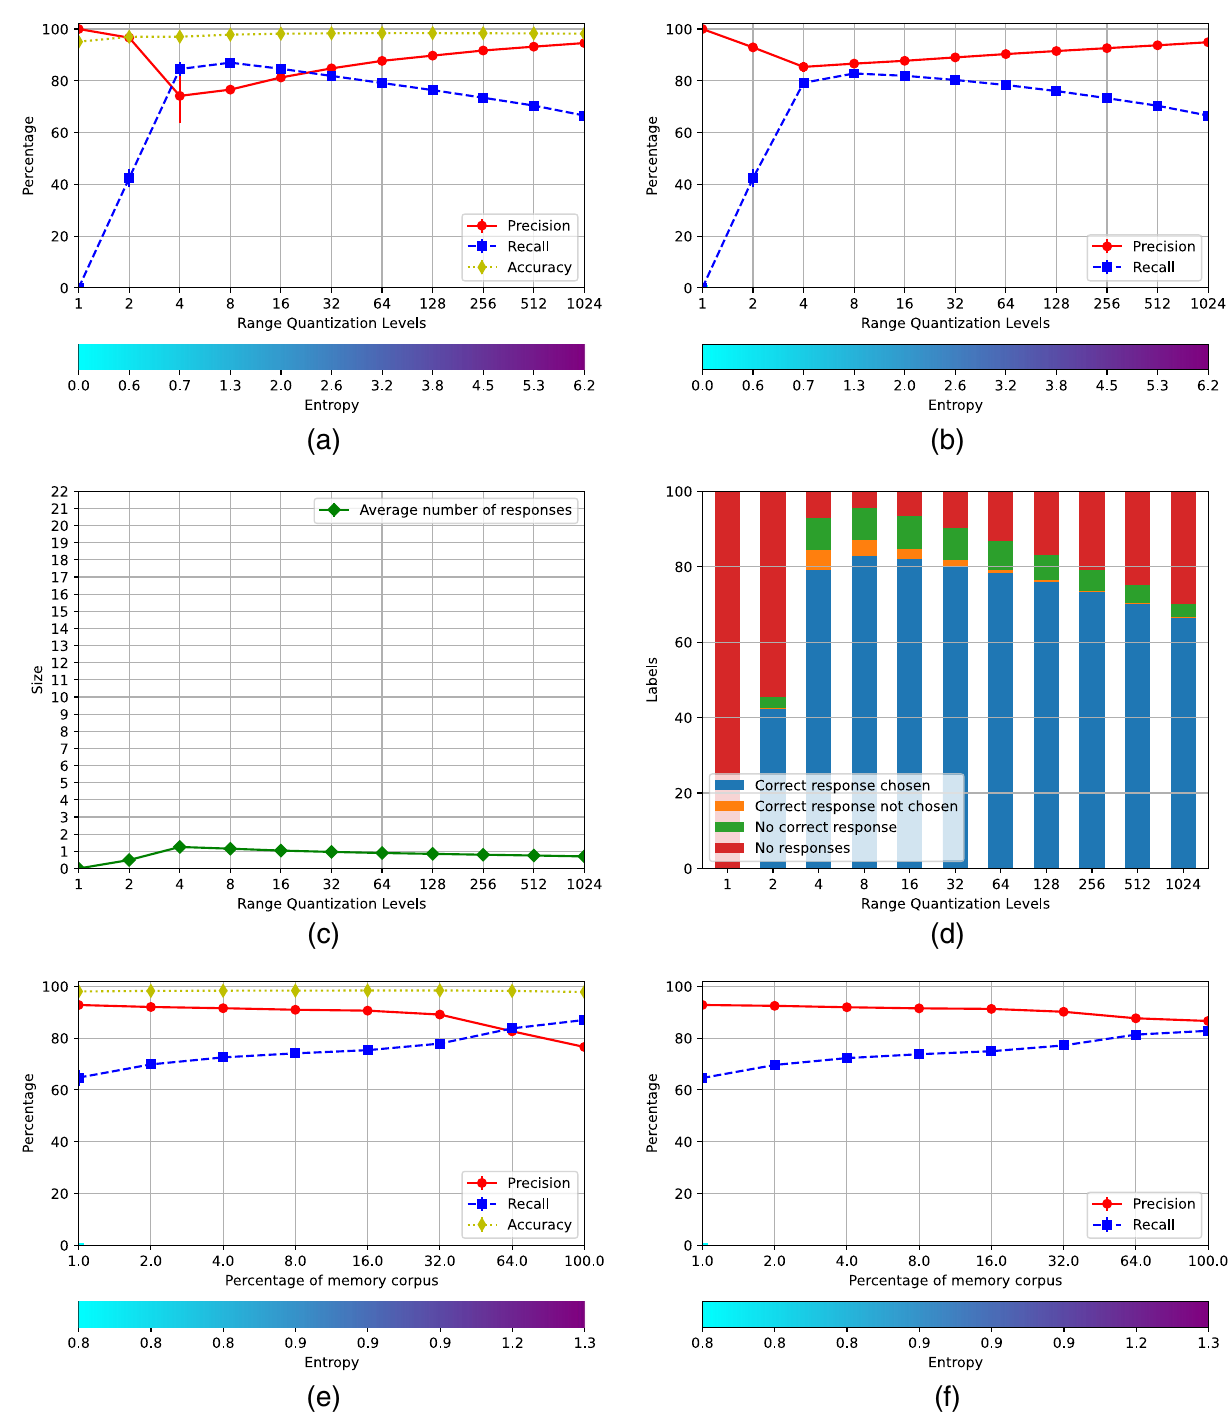
Figure 8. Scenario at the sixth stage of the learning process built upon scenario